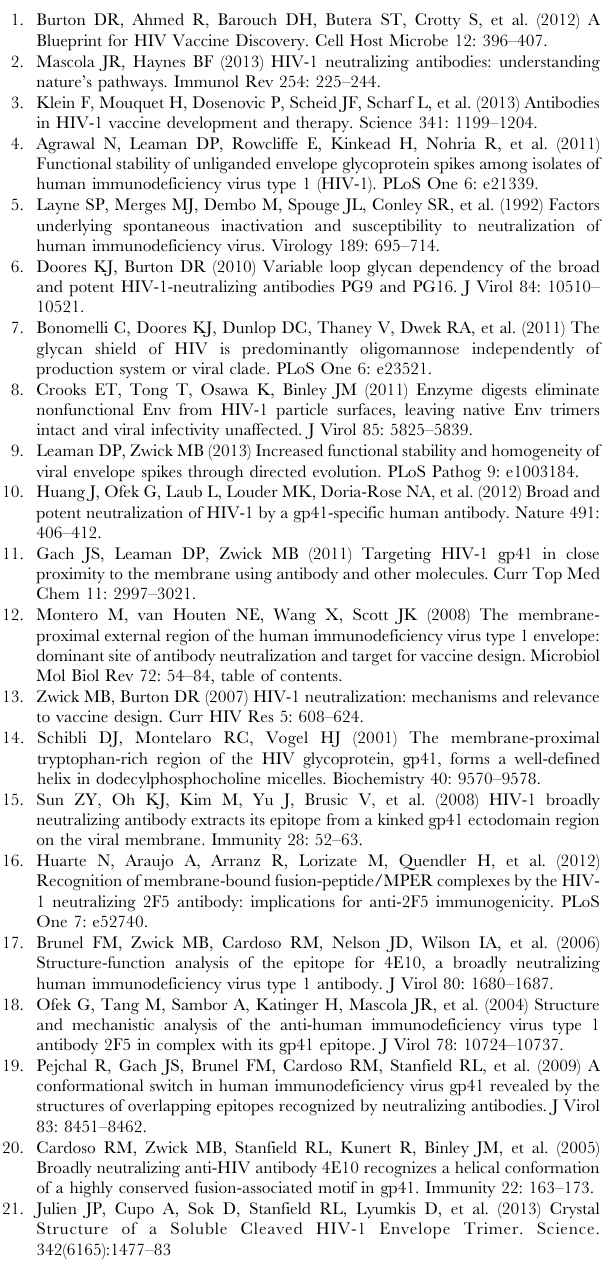
Table S1. HIV-1 isolates and variants used in this study with cognate amino acid sequences in the membrane proximal external region (MPER). Table S2. Effect of presence of 4E10 on the sensitivity of F673L mutants to MPER and CD4bs antibodies and